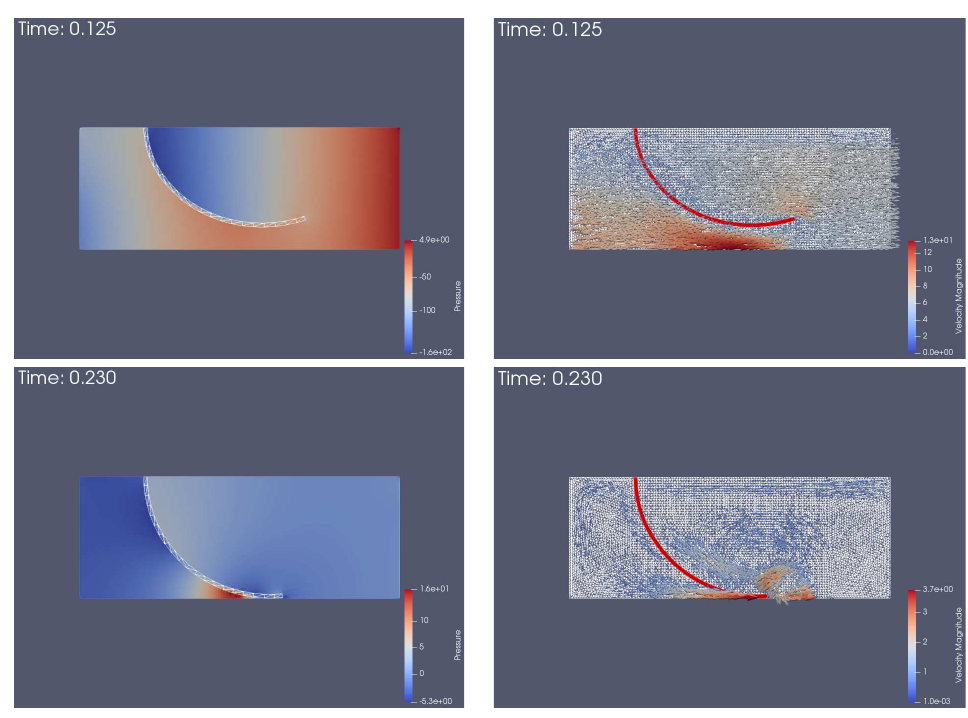
Figure 8. Computed solution for V max = 10, pressure ( left ) and velocity ( right ): when the valve was at the highest position t = 0.125 s ( top ) and when the valve made contact with the foundation t = 0.230 s ( bottom ).